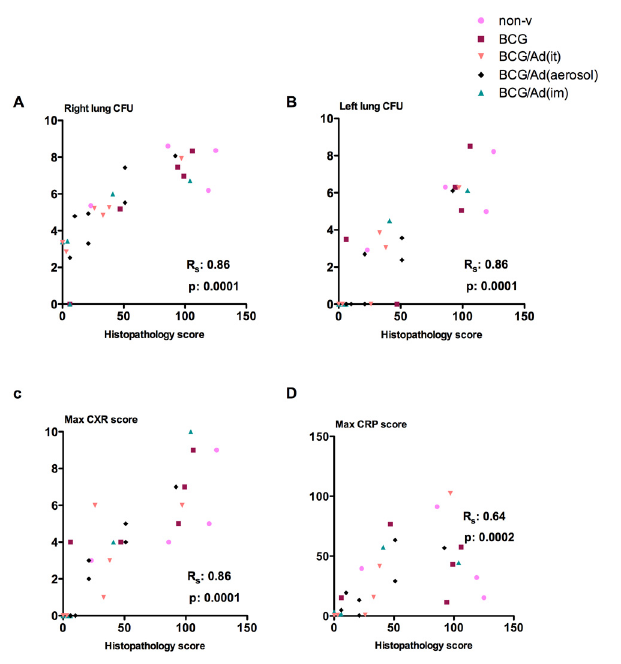
Fig 7. Correlation of lung histopathology with microbiological and clinical outcomes. Bacterial burden in the lung, chest radiography (CXR) and C-reactive protein (CPR) levels in blood correlate significantly with lung histopathology. Parameters are plotted (maximum values for each of the parameters) per individual animal (color coordination consistent throughout the article) against lung histology score for right lung ( A ), left lung bacterial burden ( B ), CXR ( C ), and CRP ( D ). Spearman ’ s rho (Rs) correlation factors and p-values are